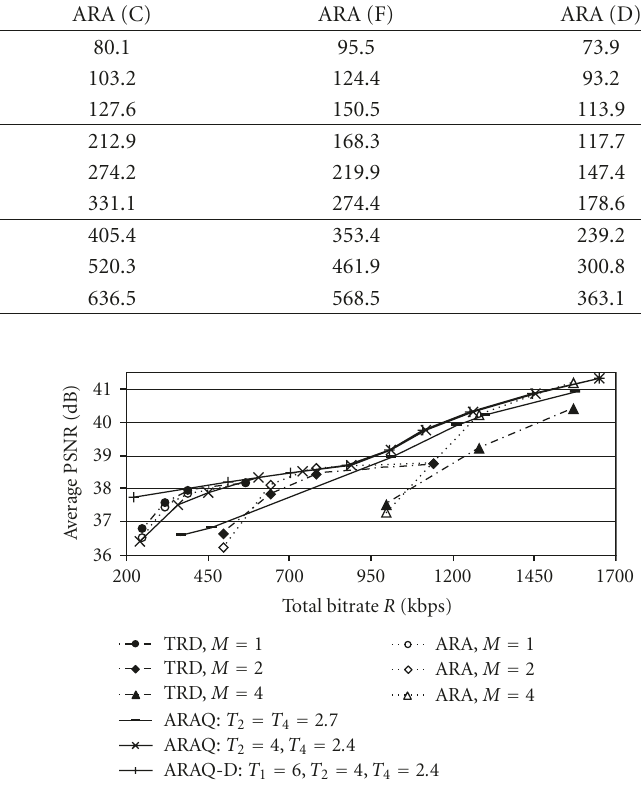
Figure 9: R-D Curves obtained with a TRD system and with the ARAQ and ARAQ-D